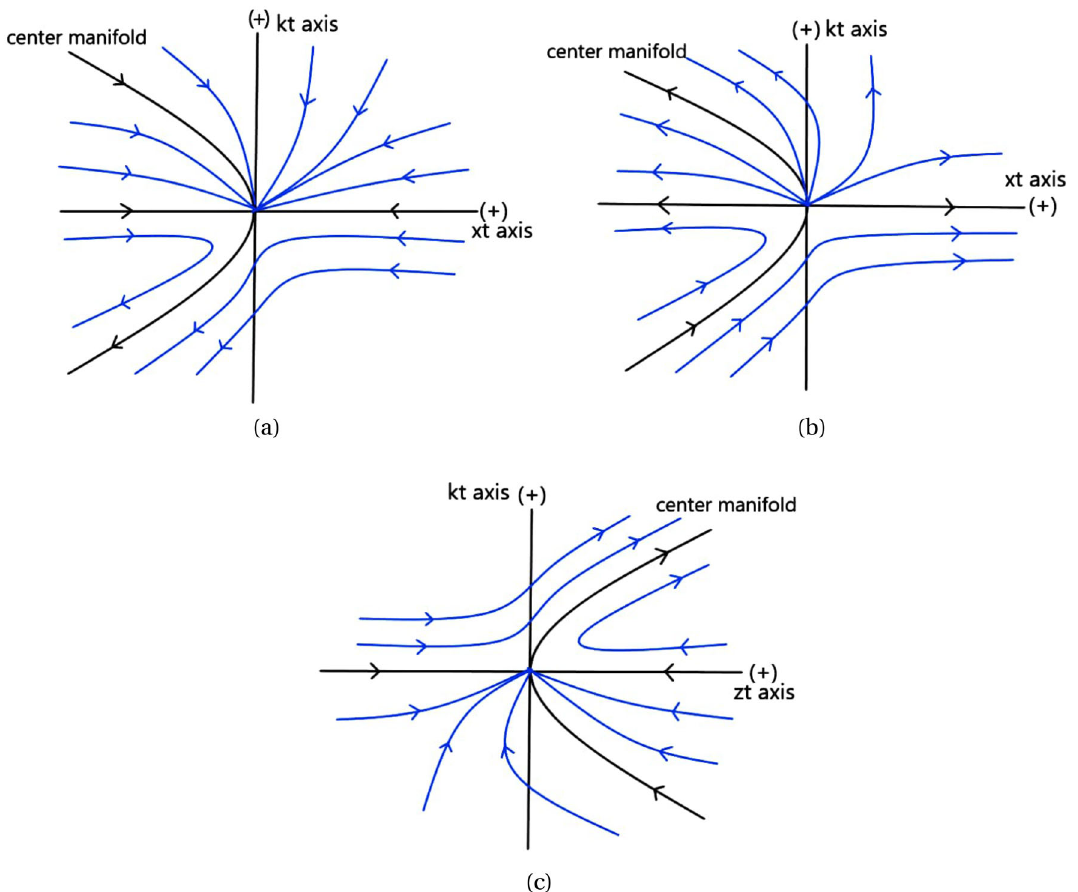
Fig. 2 The phase portrait in the proximity of the origin for the critical point B. a Represents the vector field near the origin in x t − k t plane for β > 0. b and c respectively, represent the vector field near the origin in